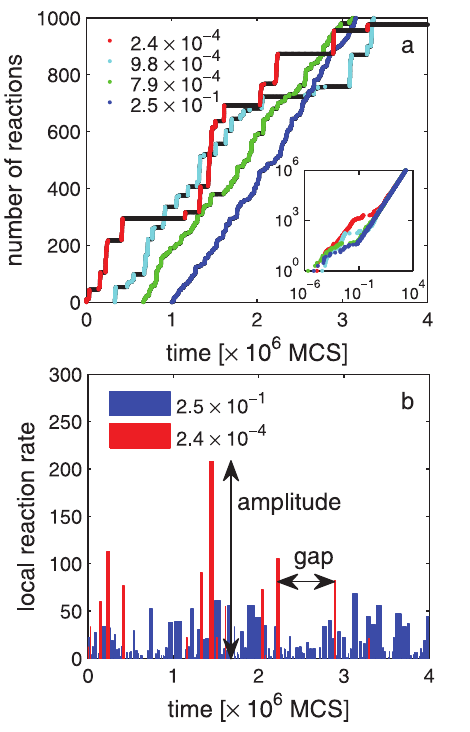
Figure 2. Total number of reactions, and local reaction rate as a function of time. a. Total number of reactions involving the tracer molecule as a function of time, obtained by Monte Carlo simulations. In all plots, black data points correspond to no activity and colored data points indicate reaction events. Different colors correspond to different confinement strengths such that P cross ~ 2 : 4 | 10 { 4 (red), 9 : 8 | 10 { 4 (cy- (cyan), 7 : 9 | 10 { 3 (green), and 0.25(blue) which represents the case of no confinement. The values of other parameters are: v ~ 1 , i.e. reactions are diffusion limited, t dim ~ 1 , N ~ 200 , L ~ 20 a , and there are 10 molecules in the lattice such that r ~ 0 : 1 . The main figure shows short samples of the simulation data, covering 10 3 reaction events for each case, and is plotted with an arbitrary offset for visual clarity. The inset shows full data sets for single runs on logarithmic axes. b. local reaction rate as a function of time for strong confinement P cross ~ 2 : 4 | 10 { 4 (red), and for no confinement P cross ~ 0.25(blue). All param- eter values are the same as in a. When confinement is strong, the local reaction rate exhibits bursts during which its amplitude is abruptly increased, that are followed by silent periods, or gaps . See the text for the details of how local rate is calculated. In b , t ~ 3 : 912 | 10 3 simulation steps.